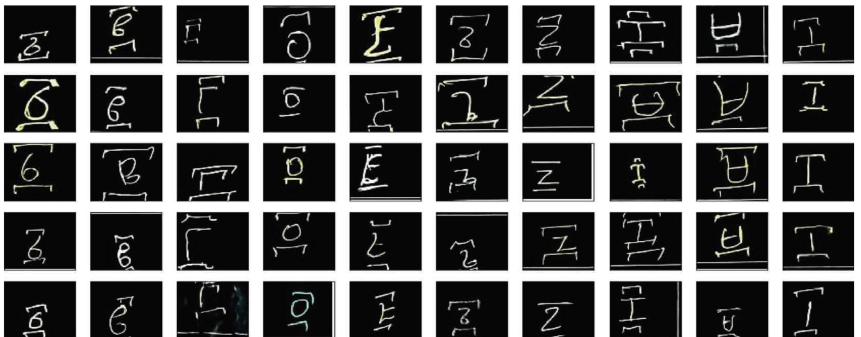
Figure 4: Sample images of the Geez handwritten digit